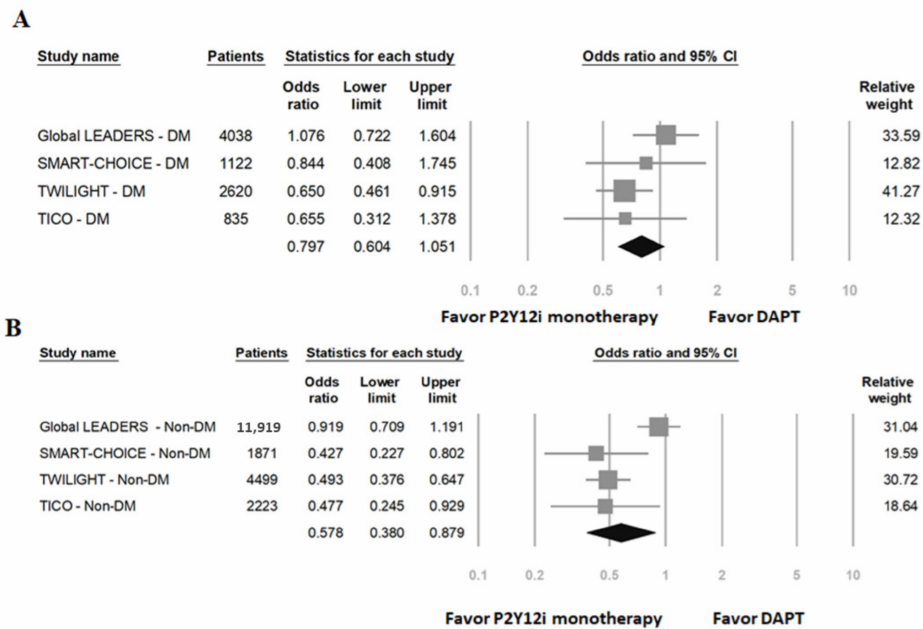
Figure 4. The primary safety outcomes (major or minor bleeding events) of P2Y12 inhibitor monother- apy compared to 12-month DAPT. ( A ) Patients with DM; ( B ) patients without